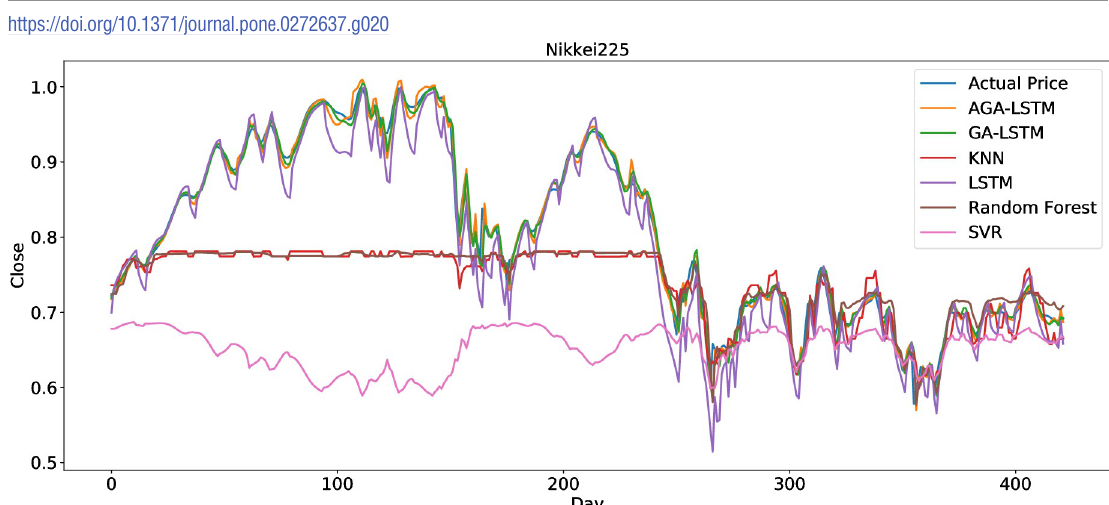
Fig 21. Comparison of AGA-LSTM and other DL models in Nikkei225 data set. https://doi.org/10.1371/journal.pone.0272637.g021 PLOS ONE | https://doi.org/10.1371/journal.pone.0272637 August 17,